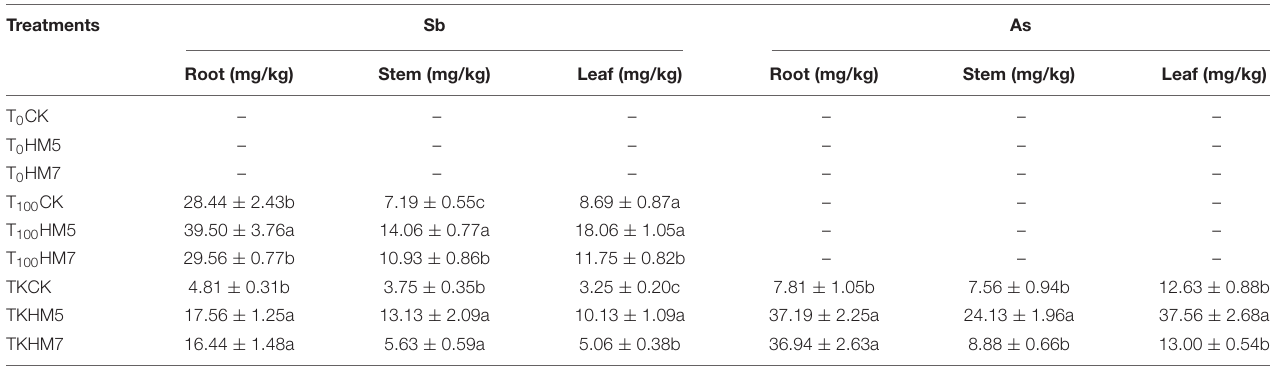
TABLE 4 | The Sb and As content of Broussonetia papyrifera under different